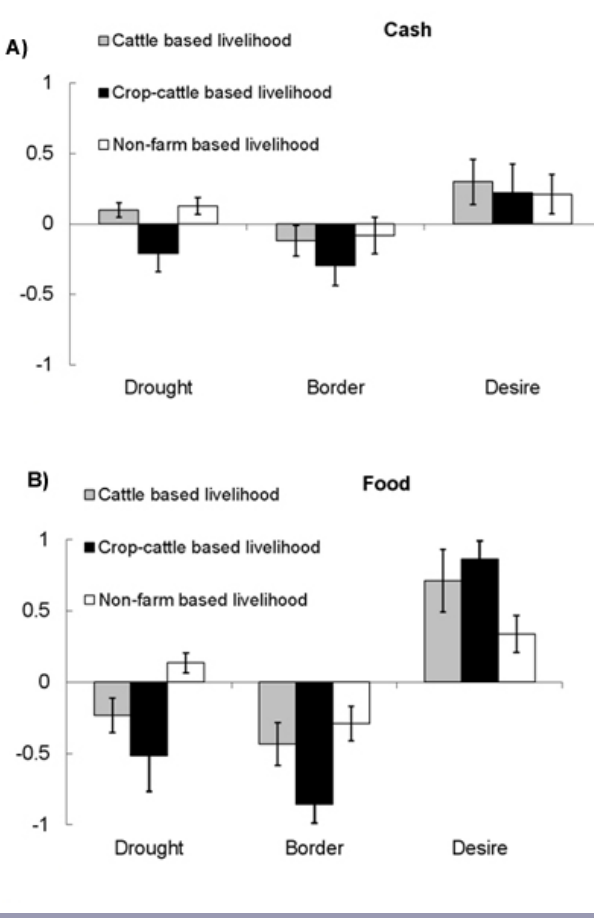
Fig. 8. Output of the Drought, Border, and Desirable scenarios for the cash situation (A) and food situation (B) of the different livelihood types in southeastern Zimbabwe lowveld. The x-axis indicates the scenario. The y-axis indicates the value for cash (A) and food (B), relative to the Baseline scenario. Error bars indicate the standard deviation of the ensemble scenario simulations in the sensitivity